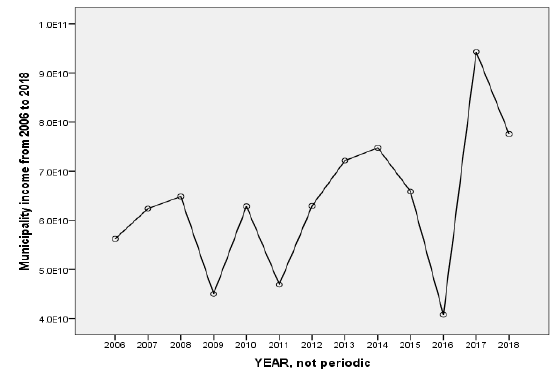
Figure 3. Status of Sanandaj Municipality Revenue between 1978 and